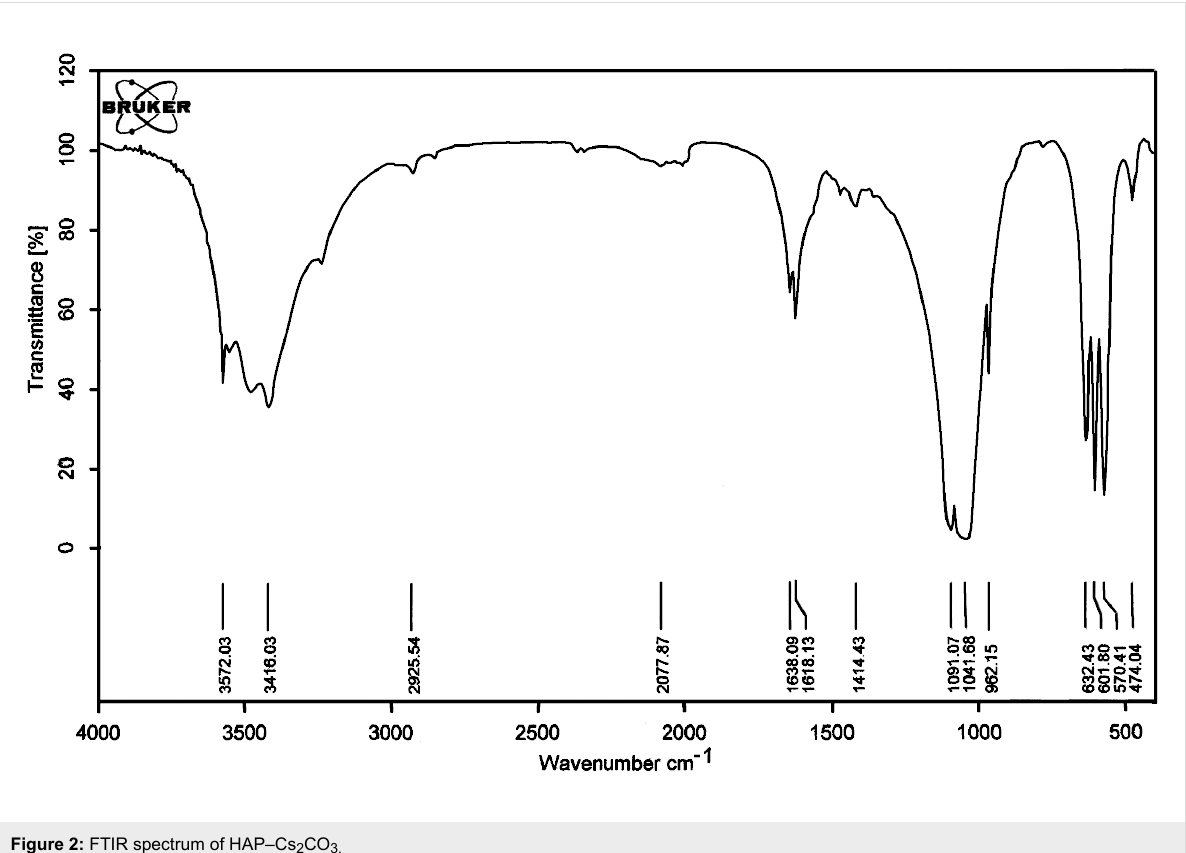
Figure 2: FTIR spectrum of HAP–Cs 2 CO